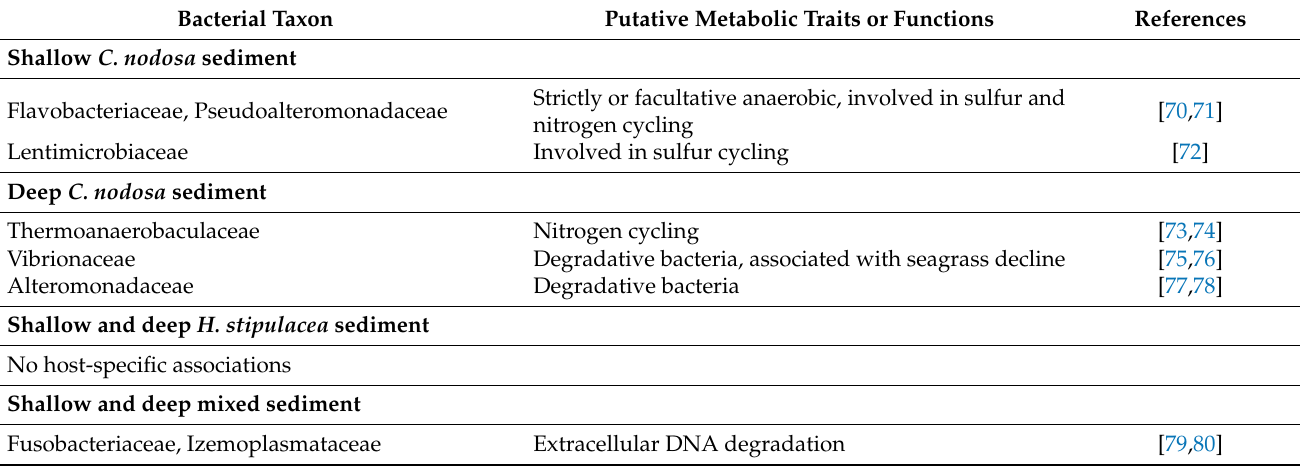
Table 5. Bacterial taxa that significantly characterize the sediment of each meadow zone, and their putative metabolic traits or